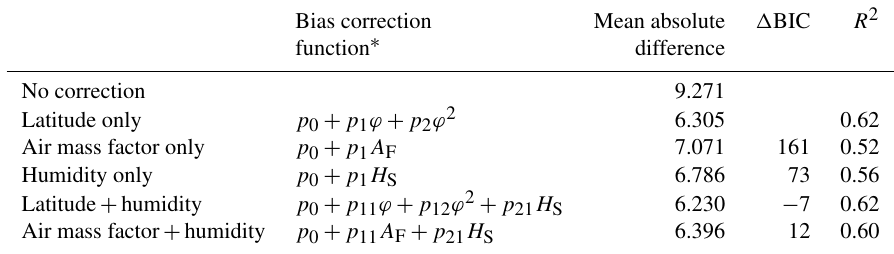
Table 1. Summary of bias correction methods and of mean absolute satellite–model difference (ppb) for 2003–2005 before and after applying bias correction. (cid:49) BIC is the BIC score increase of a bias correction method when referring to the latitude-only